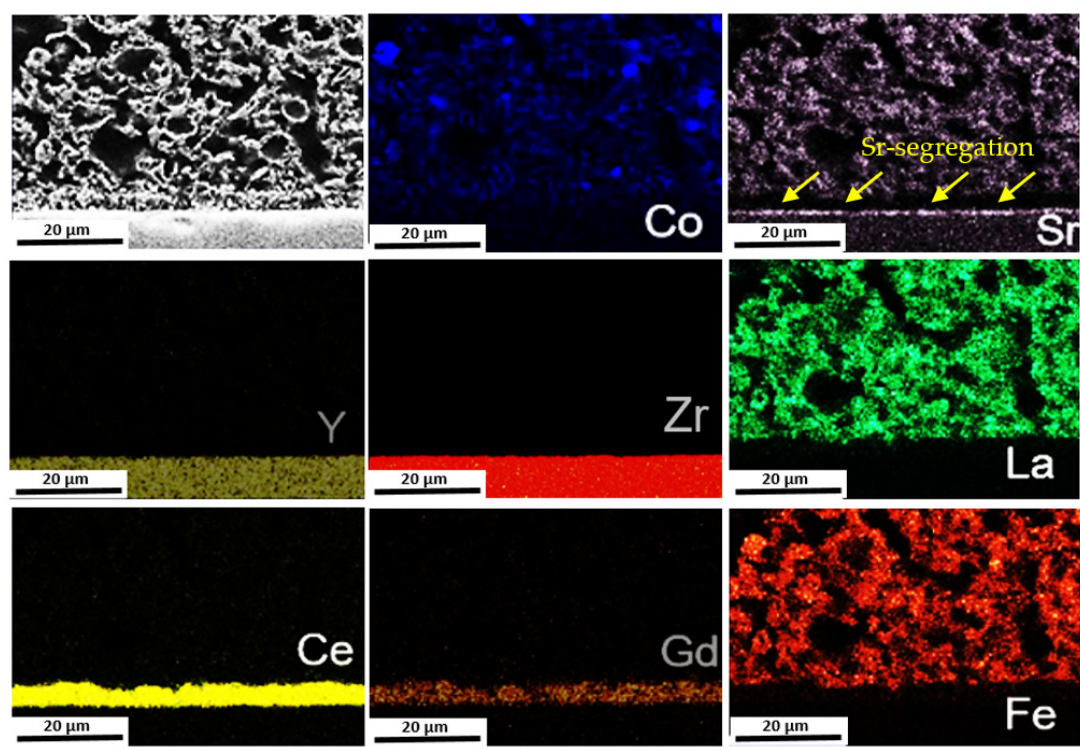
Figure 5. Elemental mapping on the oxygen electrode side, at the cross-section of the 3Mo-3Au-Ni- GDC/8YSZ/GDC/LSCF single cell after 1700 h steam electrolysis operation at 900 °C with 63 vol.% H 2 O + 30 vol.% N 2 + 7 vol.% H 2 feed gas mixture and − 0.3 A ‧ cm − 2 current load.